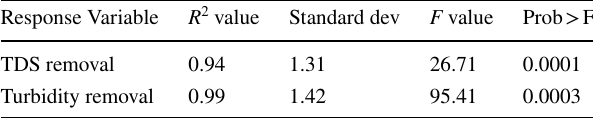
Table 4 Analysis of variance (ANOVA) results Response